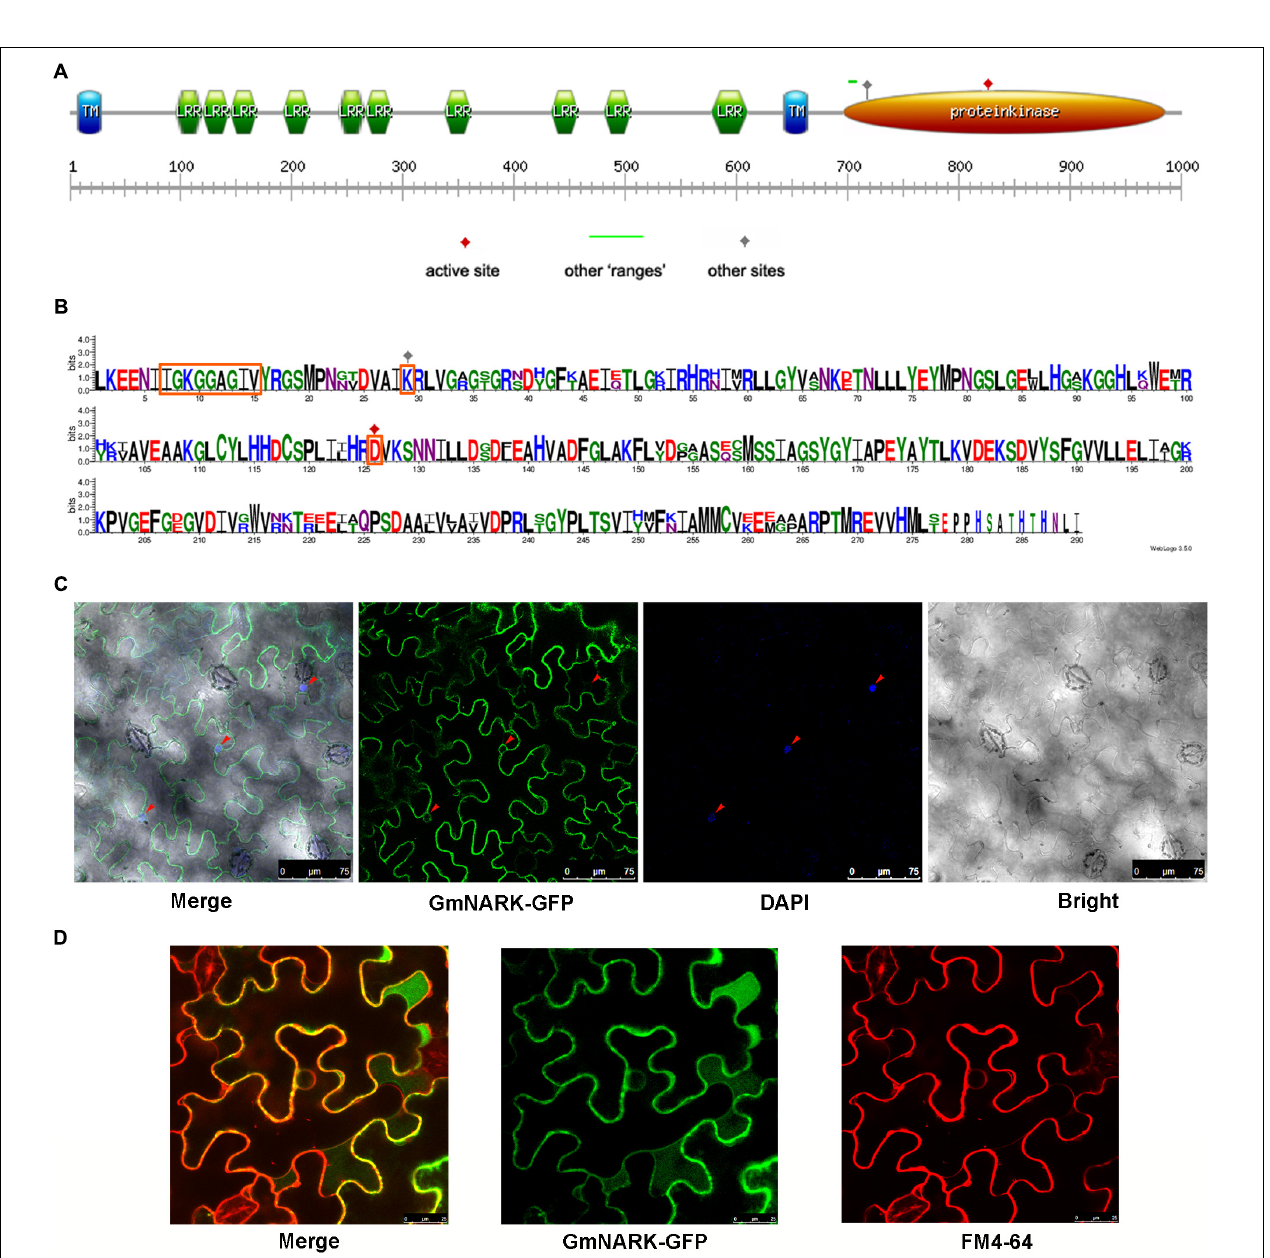
FIGURE 4 | GmNARK protein structure analysis and subcellular location. (A) Protein domain analysis of GmNARK. (B) Protein sequence alignment between GmNARK and AtCLV1. (C) Sub-cellular location analysis of GmNARK-GFP. The image of GmNARK-GFP and DAPI fluorescence in Nicotiana benthamiana cells. (D) Sub-cellular location analysis of GmNARK-GFP. The image of GmNARK-GFP and membrane staining marker (FM4-64) fluorescence in N. benthamiana cells.